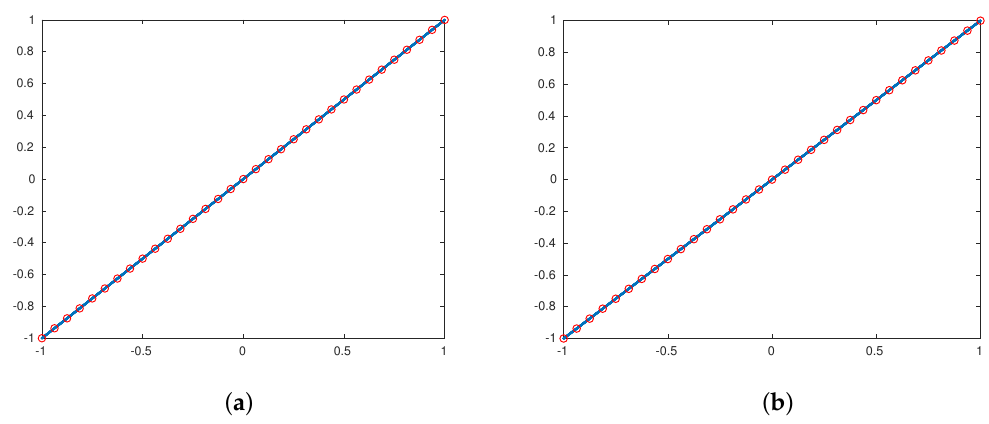
Figure 6. The limit functions in 1d using five subdivision scales; the results shown in ( a , b ) were obtained by S 0 (8) and S 1 (10), respectively, where w = 1 represented in ◦ .